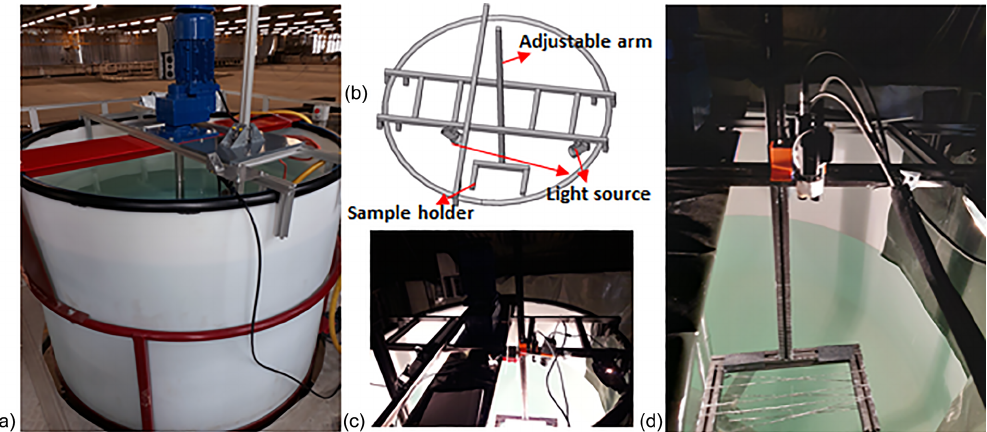
Figure 1. (a) Original set-up of the tank; (b) schematic of the aluminium frame; (c) experimental set-up of the tank inside, covered with black cloth; and (d) foreoptic ends of the ASD and SEV spectroradiometers. Table 1. Hyperspectral-radiometer specifications and settings during the study. VNIR: visible–near infrared; SWIR: shortwave infrared. ASD SEV Spectral range (nm) 350–2500 280–2500 Spectral resolution (nm) VNIR: ca. 3nm 4nm (280–1000nm) ≤ 10nm (1000–1900nm) SWIR: 10–12nm ≤ 7nm (2100–2500nm) Scans per measurement 30 30 Replicate measurements 5 5 Foreoptic field of view 8 ◦ 8